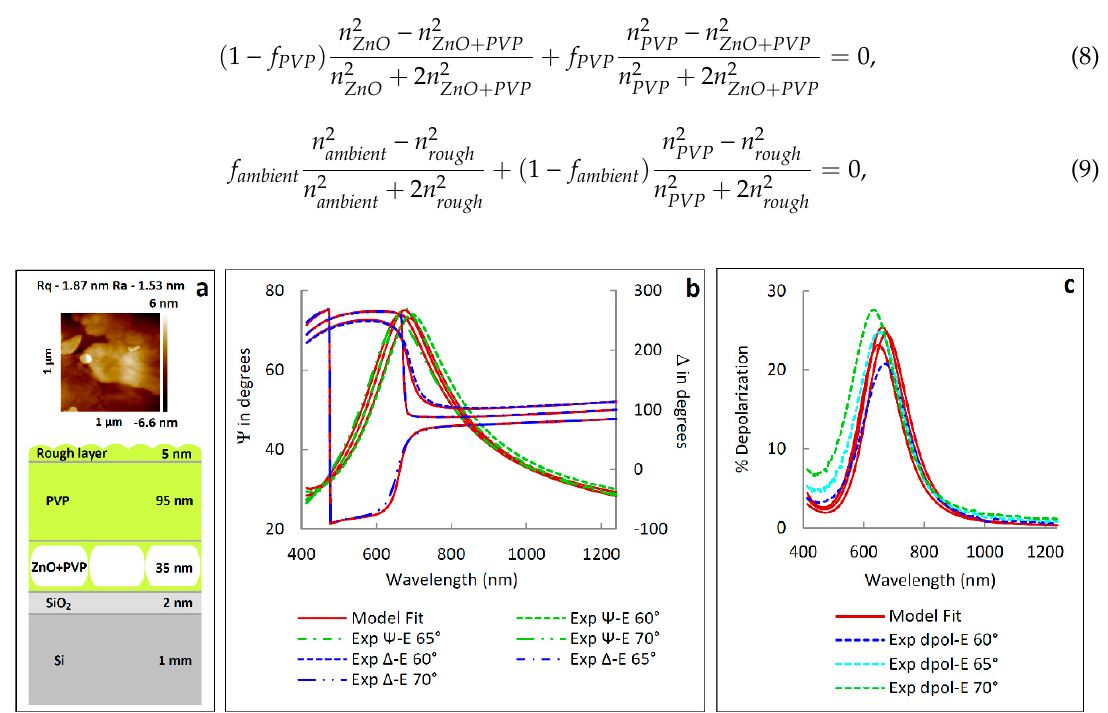
Figure 15. ( a ) AFM image and ( b ) optical model of the ZnO/PVP multilayer system model. ( c , d ) The measured and calculated Ψ and Δ azimuths as well as depolarization factor %Depol for the Si/SiO 2 /ZnO + PVP sample. The value of χ 2 =